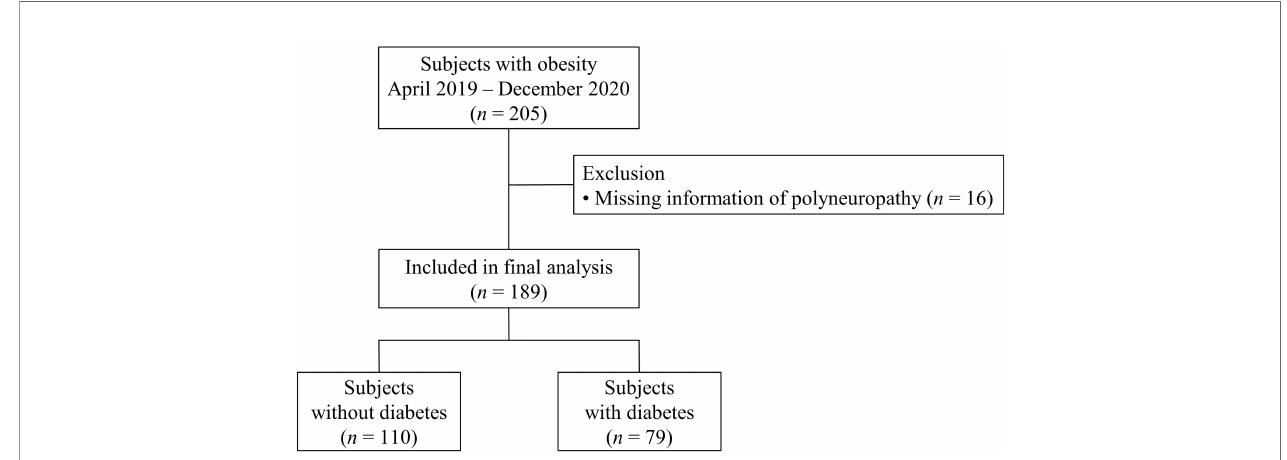
FIGURE 1 | Flow chart of the selection of subjects for the analysis. Among 205 obese subjects, after excluding subjects with missing information of polyneuropathy, 189 subjects were included in the fi nal analysis. They were divided into two groups according to diabetes